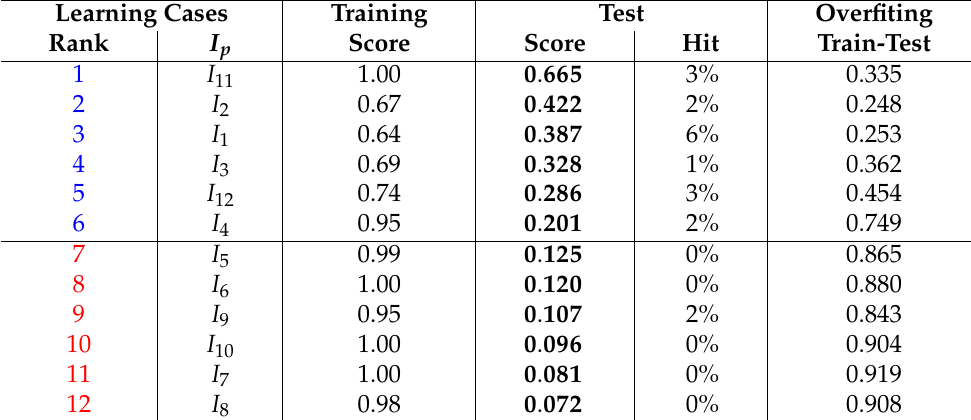
Table 3. Experimental results from the preliminary analysis using 12 learning cases manually selected, which are sorted according to their ‘Test Score’ shown in bold and they are grouped into two sets: in blue are the cases that get higher scores and, in red, the cases with lower